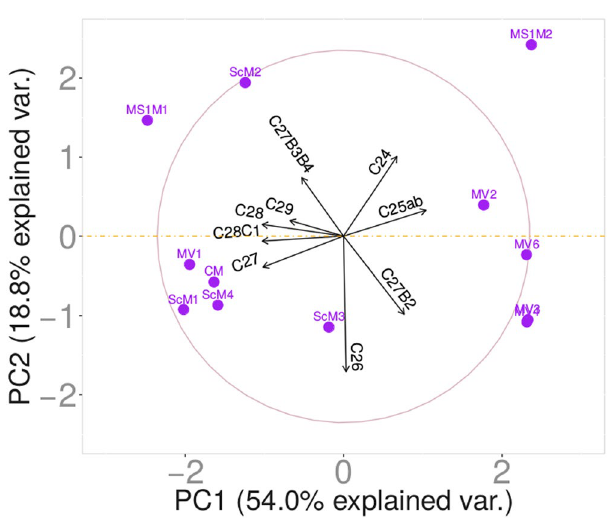
Figure 4. Representation of mauveine samples obtained from the new synthesized and historical collections on the first two components, recovering 72% of